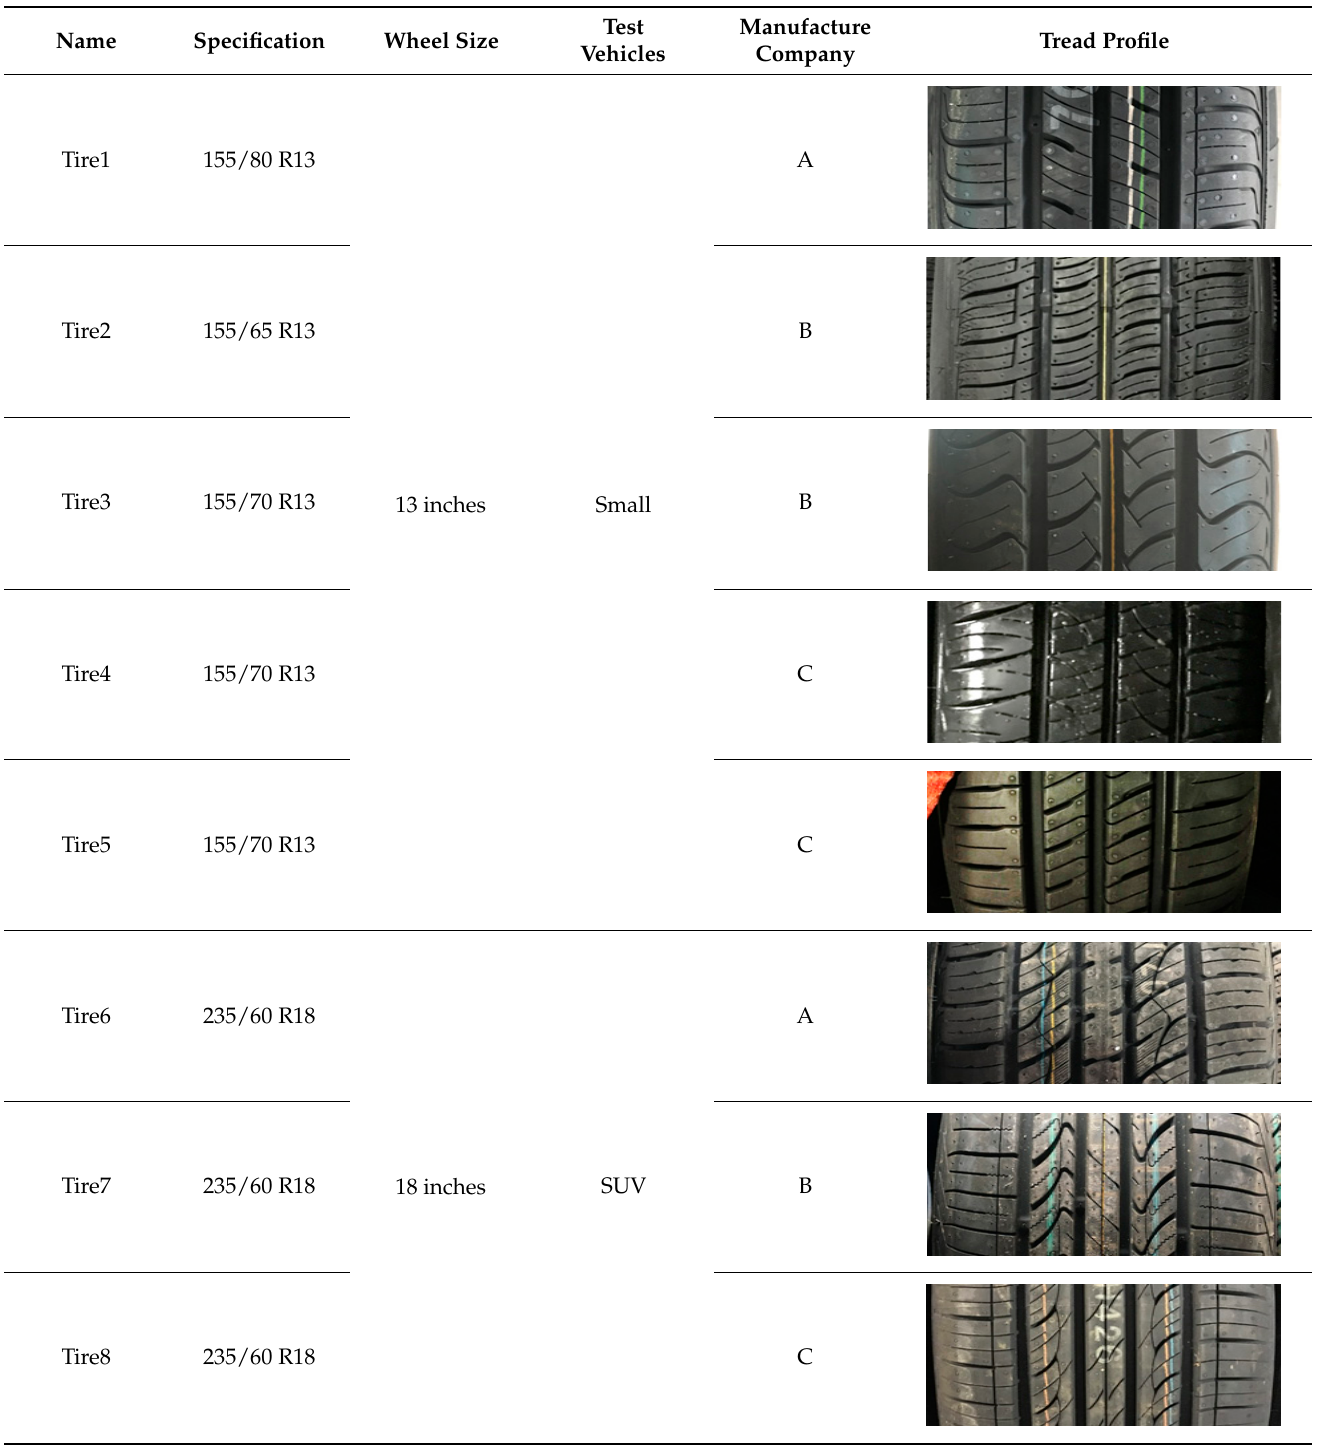
Table 2. Tire dimensions selected for driving simulation test.